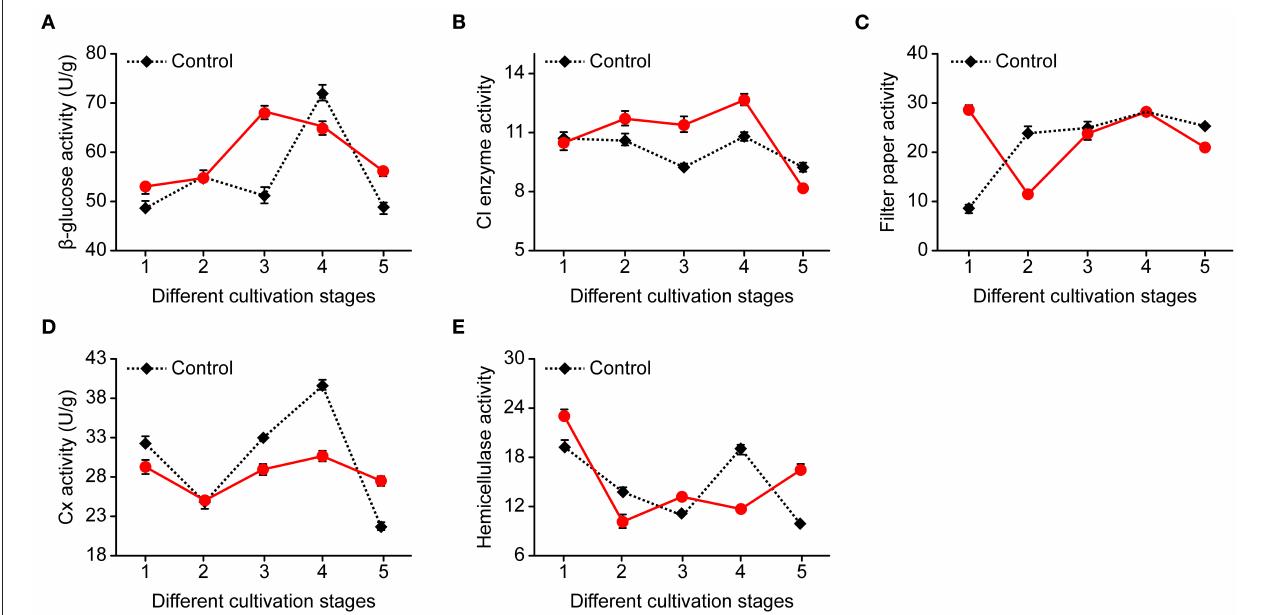
FIGURE 4 | Effects on cellulase activity at different cultivation stages between treatments of 0.08% NaAc and the control. (A) β -glucose activity. (B) C l activity. (C) Filter paper activity. (D) Cx activity. (E) Hemicellulase activity. 1, heavy water stage; 2, needle stage; 3, primordia formation stage; 4, egg stage; and 5, harvest stage; n = 3 at each